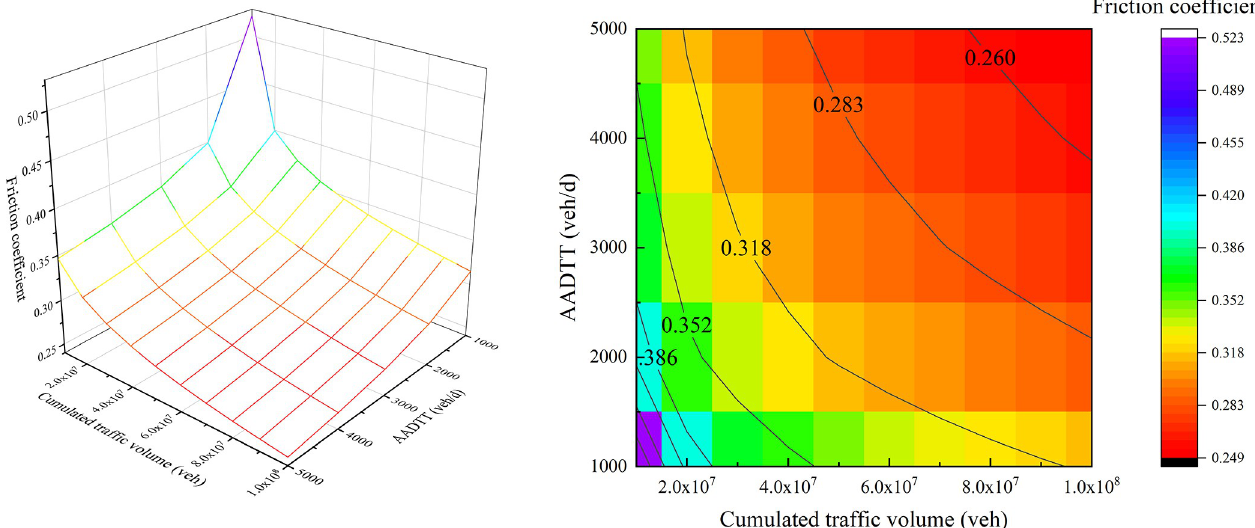
Fig 5. Evolution of friction coefficient under traffic flow: (a) 3D surface graph, (b) heat map.